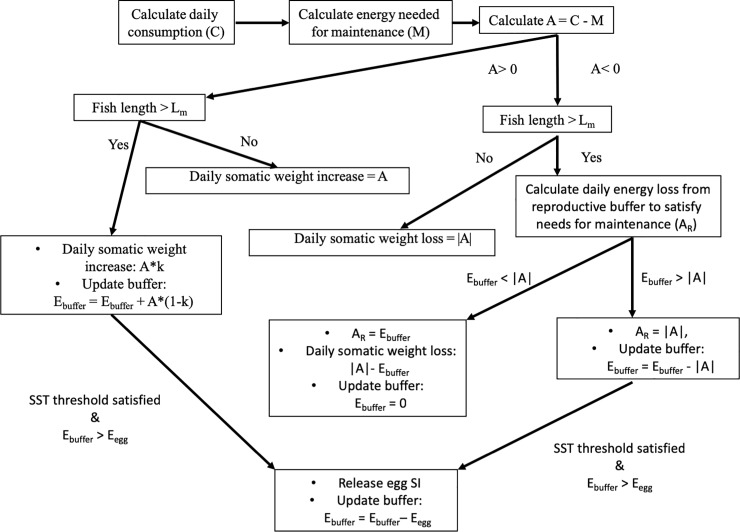
Schematic illustration of the energy allocation and egg production algorithm.SST: Sea surface temperature. Lm: length at maturity. Ebuffer: energy in reproduction buffer. Eegg: batch energy.